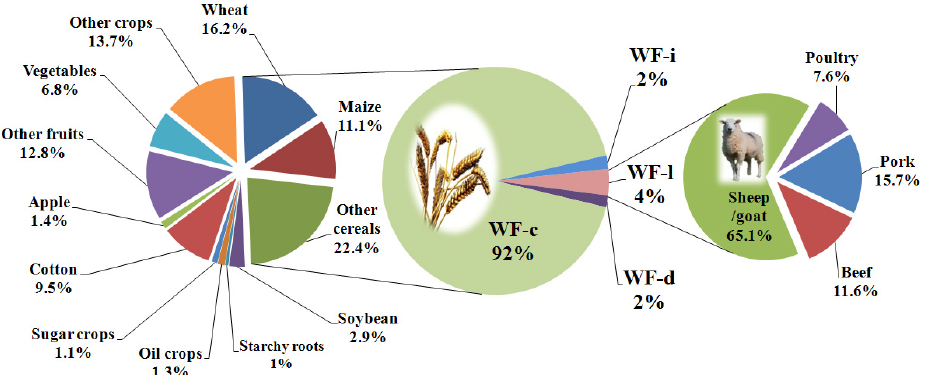
Fig. 6. Water footprint (WF) in the HRB over